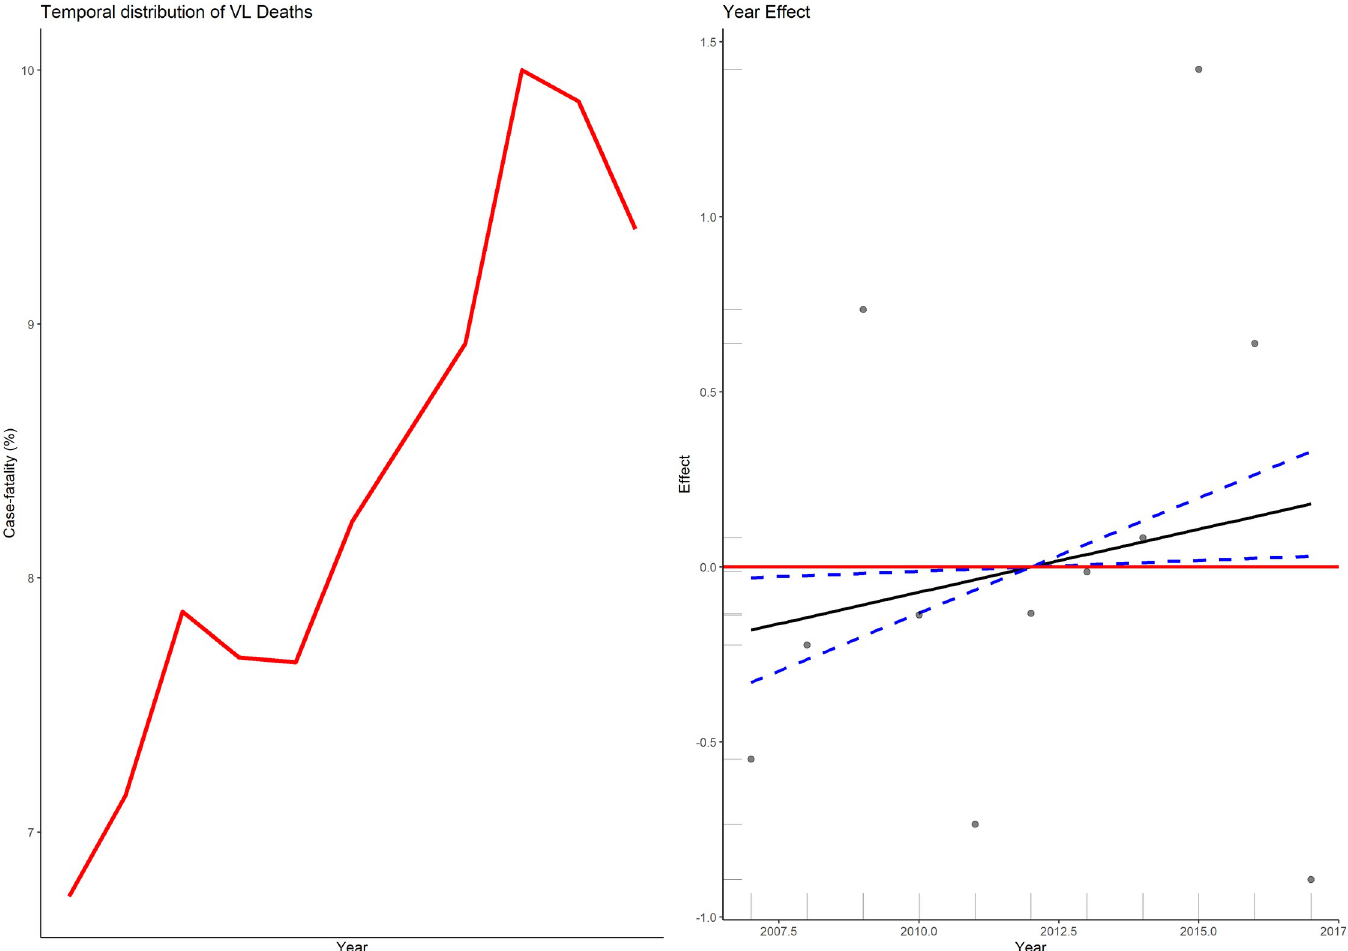
Fig 1. Observed annual distribution of case-fatality rate (a), and temporal effect estimated by generalized additive model (b).